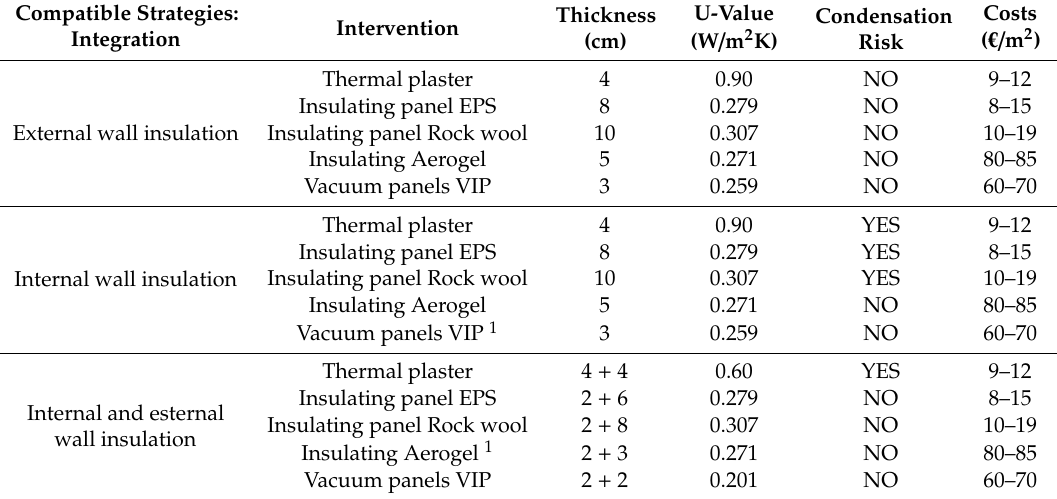
Table 6. Summary of the energy interventions studied for the stone